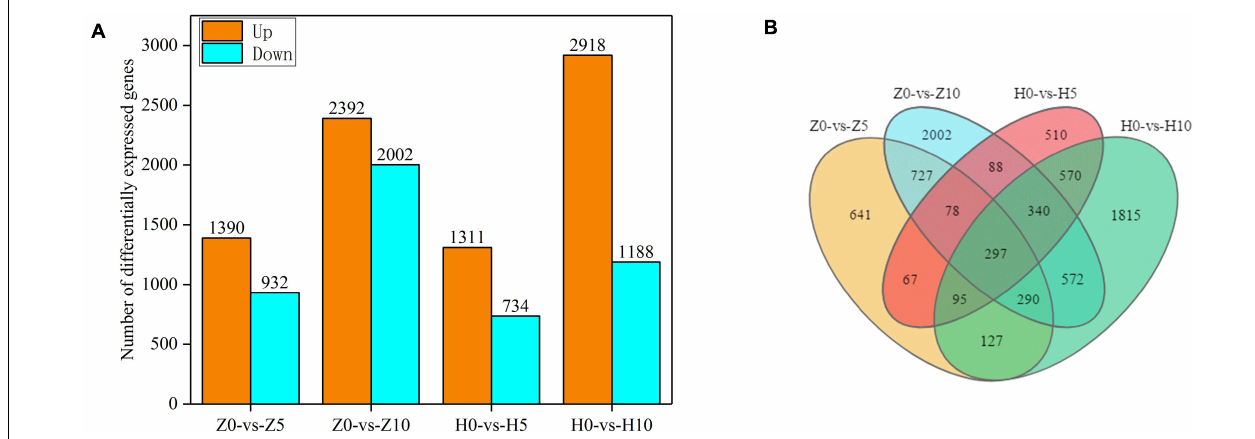
FIGURE 3 | Gene expression of peanut leaves under waterlogging. (A) Comparison of the up- and downregulated gene expressions between normal supply and waterlogging (5 and 10 days) in Zhongkaihua 1 (ZKH 1) and Huayu 39 (HY 39). (B) Venn diagram of the differentially expressed genes (DEGs) of ZKH 1 and HY 39 under waterlogging. Z0, Zhongkaihua 1 without waterlogging; Z5, Zhongkaihua 1 with 5 days of waterlogging; Z10, Zhongkaihua 1 with 10 days of waterlogging; H0, Huayu 39 without waterlogging; H5, Huayu 39 with 5 days of waterlogging; H10, Huayu 39 with 10 days of waterlogging. The same below. Z0-vs.-Z5, comparison between Zhongkaihua 1 with 5 days of waterlogging (Z5) and Zhongkaihua 1 without waterlogging (Z0); Z0-vs.-Z10, comparison between Zhongkaihua 1 with 10 days of waterlogging (Z10) and Zhongkaihua 1 without waterlogging (Z0); H0-vs.-H5, comparison between Huayu 39 with 5 days of waterlogging (H5) and Huayu 39 without waterlogging (H0); H0-vs.-H10, comparison between Huayu 39 with 10 days of waterlogging (H10) and Huayu 39 without waterlogging